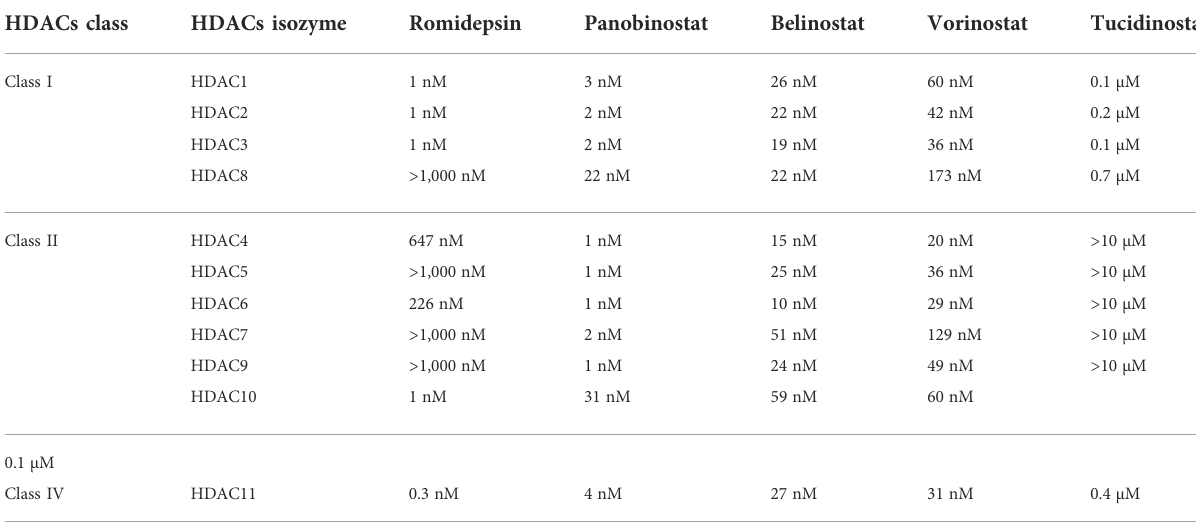
TABLE 2 IC 50 values of HDACs